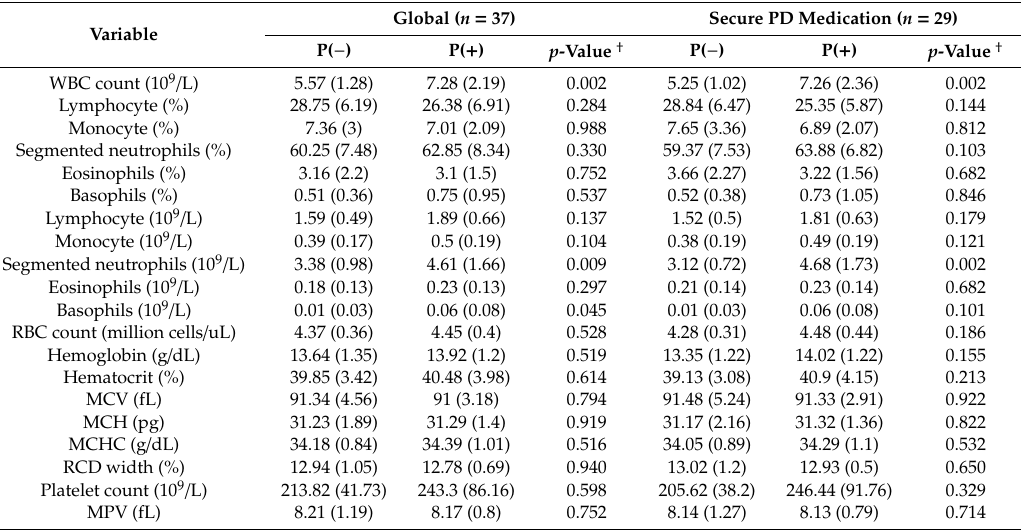
† Mann-Whitney for continuous variables without normal distribution and t -test for continuous data with normal distribution, p < 0.05. Lymphocytes (%), Segmented neutrophils (%), RBC, Hemoglobin, Hematocrit, MCV and MCH were compared with t -test, and remaining with Mann-Whitney test. P( − )—No Periodontitis, P( + )—Periodontitis;